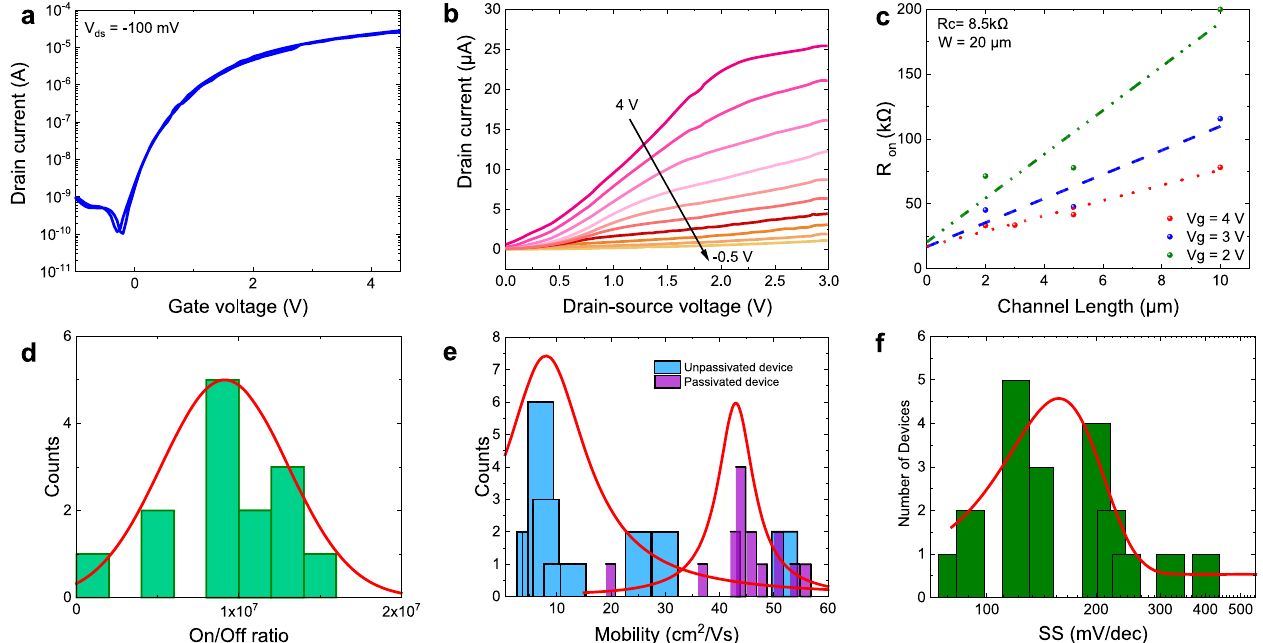
Fig. 7 Electrical measurements results of the fl exible MoS2 FETs. a Transfer and b output characteristics of a typical FET with channel length of 5 µm and width of 20 µm. c Contact resistance calculated from the on-state resistance of the FETs with different channel lengths. Histograms showing distribution of device d on/off ratio, e fi eld-effect mobility, and f subthreshold slopes (SS) of several measured devices over a 5 × 5 mm 2